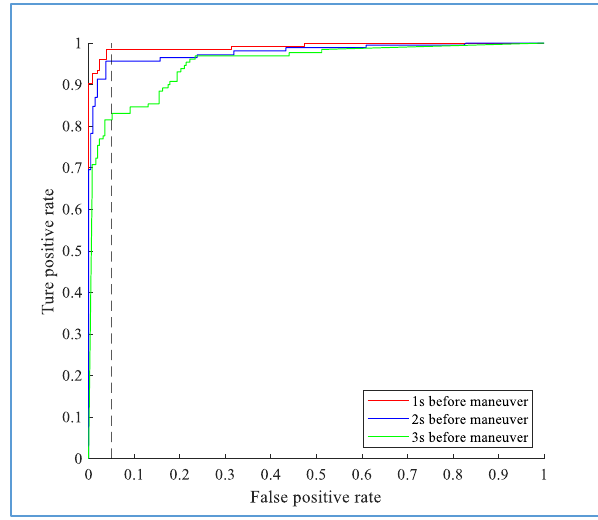
Figure 16. Performance of the proposed method at di ff erent times before the actual maneuver for the TL.